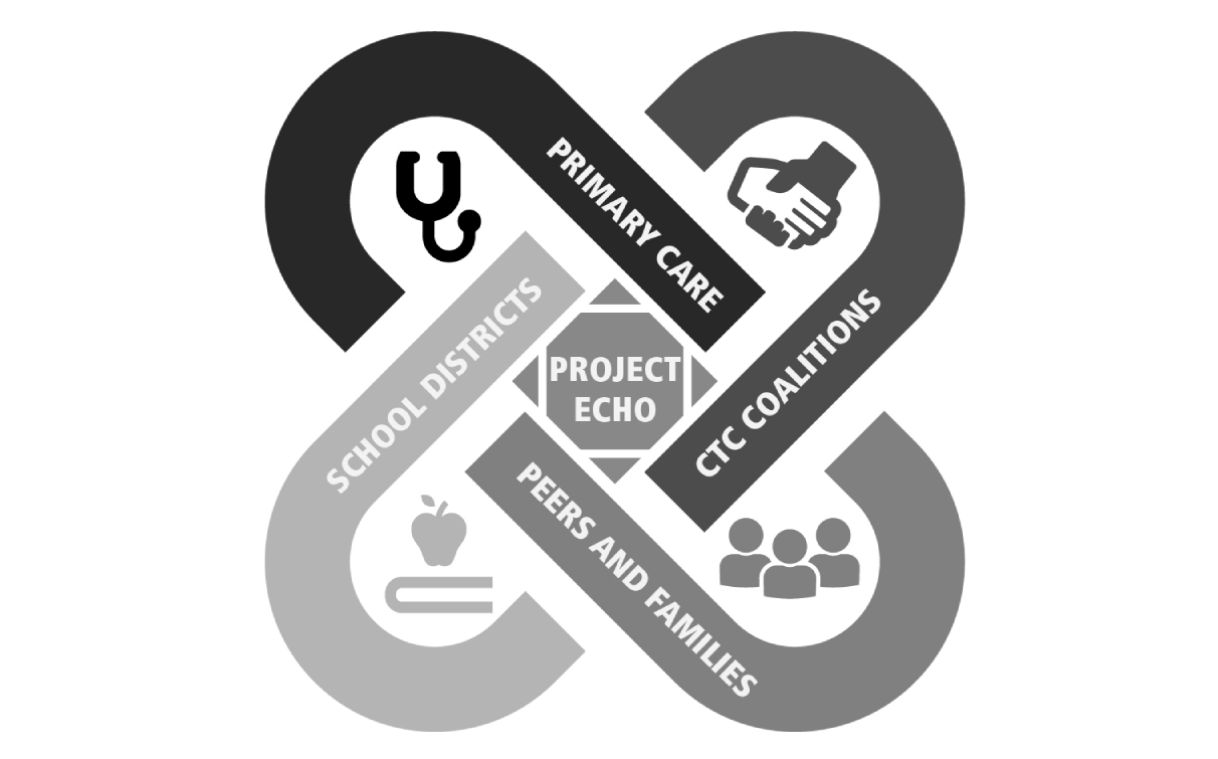
Figure 3. This is a collaboration between primary care providers and school districts, with input from communities that care coalitions and outreach to peers and